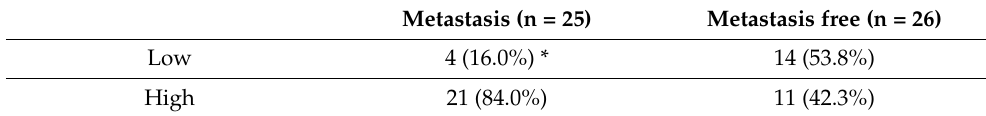
Table 5. Number of uveal melanoma (with and without metastasis) with low and high HO-1